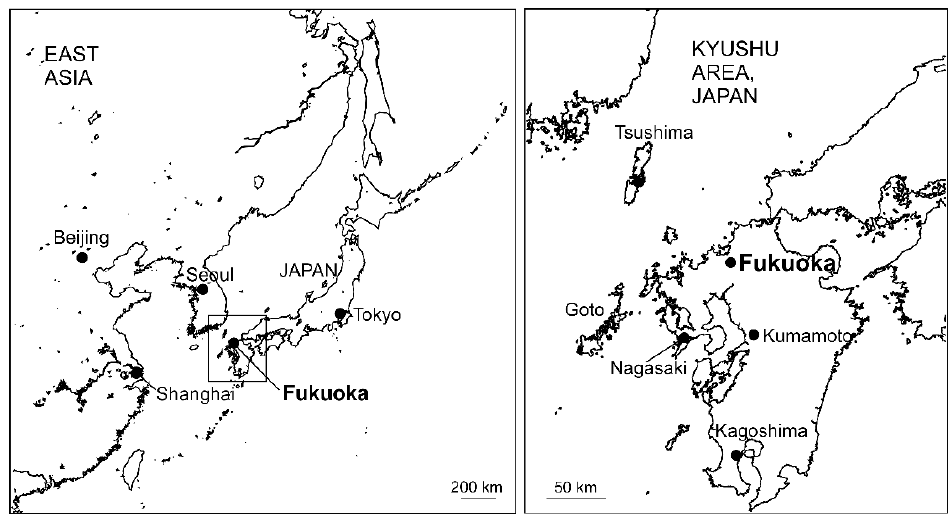
Figure 1. Location of Fukuoka city. The upper direction indicates North. The instruments were set in the laboratory on the fourth floor of the 18th building at a height of approximately 15 m. The inlet for both gaseous species and PM was separately projected from the windows. Teflon tubes were used for the gaseous species, and stainless tubes were used for PM. The laboratory was air-conditioned, and the room temperature was maintained at approximately 20 ◦ C during the observation period [4]. The measurement period was from 20 January to 10 February,